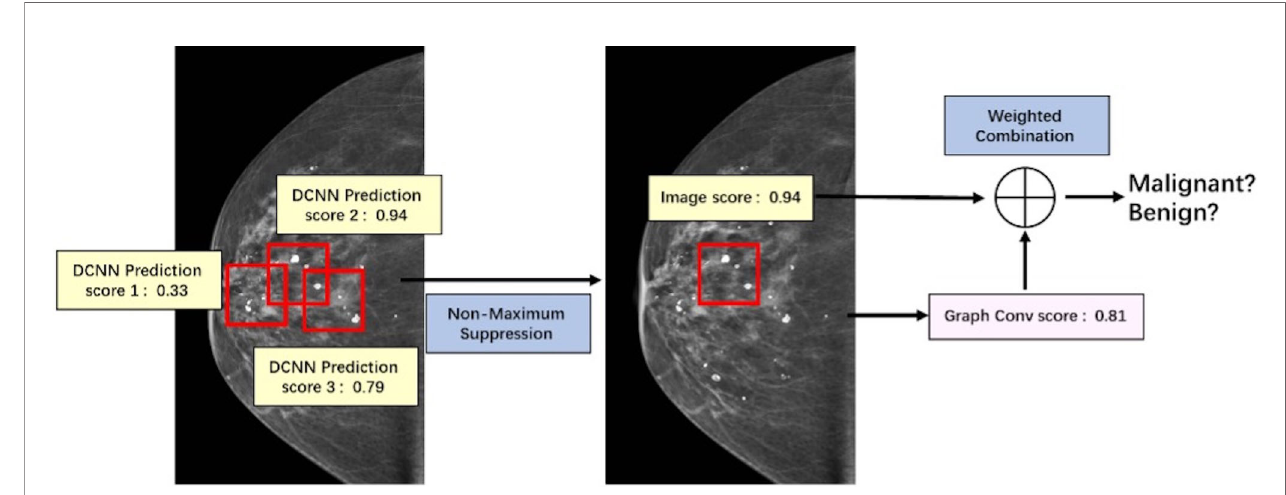
FIGURE 6 | Illustration of fusion process of discriminant model.